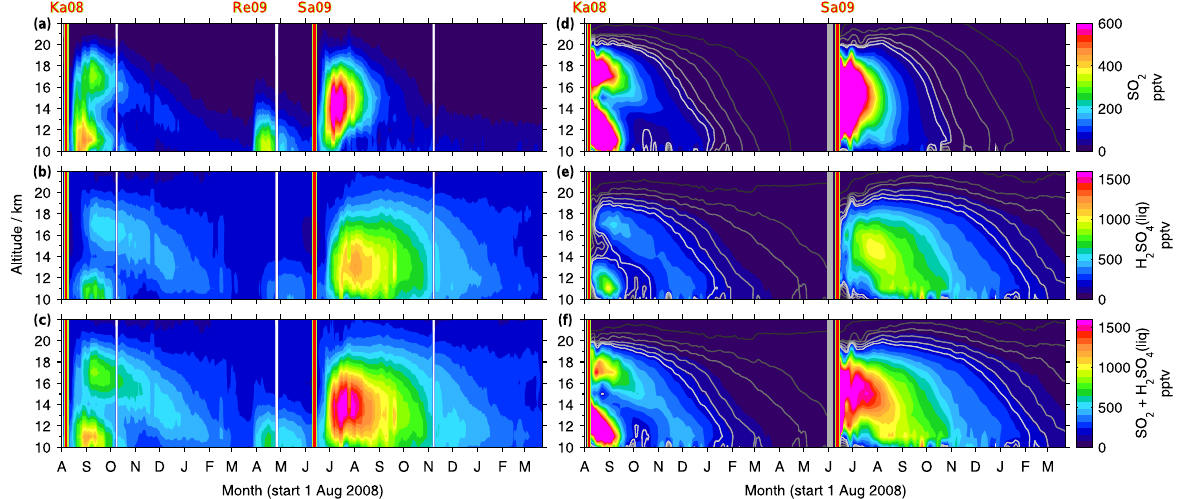
Figure 7. SO 2 , liquid-phase H 2 SO 4 , and total sulfur (SO 2 + H 2 SO 4 ) volume mixing ratios by MIPAS (a–c) and the CTM (d–f) . Vertically resolved time series of SO 2 and sulfate aerosol for 30–90 ◦ N, starting on the 1 August 2008 (area weighted 5d running means). Indicated are the days of the eruptions of the volcanoes Kasatochi in August 2008, Redoubt in March 2009, and Sarychev in June 2009, which were observed by MIPAS. Redoubt is not considered in the model. The colour scale is restricted to 0–800pptv (SO 2 ) and 0–1600pptv (sulfate aerosol and the sum of SO 2 and sulfate aerosol). Exceeding values are assigned the respective limiting value. The CTM contour lines in dark to light grey represent 1, 5, 10, 20, 30, and 40pptv in the case of SO 2 and 5, 25, 50, 100, 150, and 200pptv for sulfate aerosol and the sum of SO 2 and sulfate aerosol. For the CTM, two simulations are shown: from August 2008 to May 2009 and from June 2009 to May 2010, separated by a thick grey